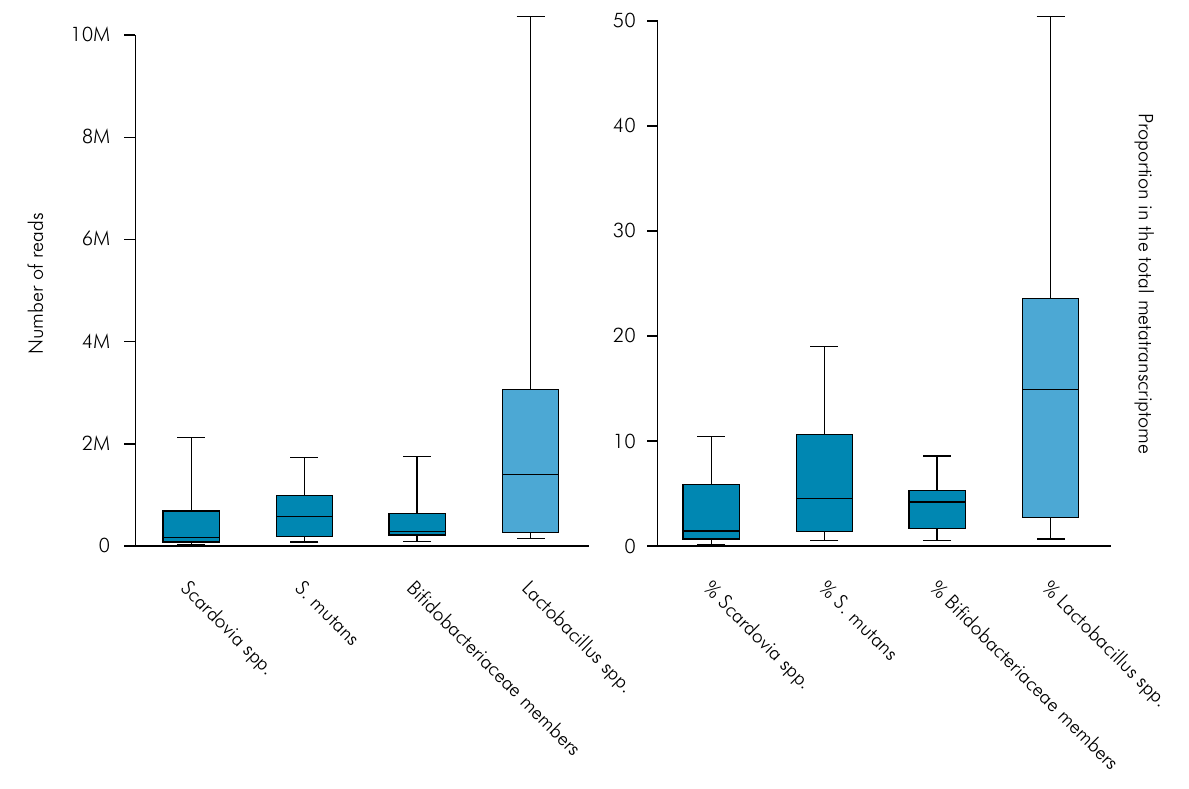
Figure 1. Number of reads and percentage in the total metatranscriptome of root caries biofilms of Scardovia spp., Bifidobacteriaceae members, Lactobacillus spp. and Streptococcus mutans (pipeline